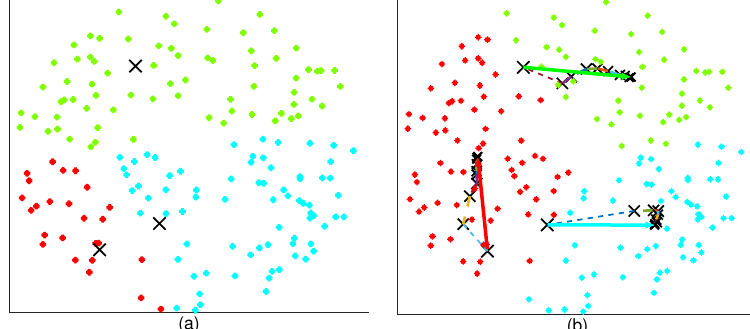
Figure 4. Illustration of the movement of the aerial base stations (ABSs) in the 2D plane for suburban environment. The position of the ABS is represented using x . The three colors differentiate the UE clusters of the respective ABSs. ( a ) Initial 2D position of the ABSS. ( b ) Movement of the ABSs to the computed position. The solid arrow represents the actual ABS movement. The doted lines represent the adaptive process (does not represent the movement) performed at the CC. R B = 2000 m, α N = 2.5, α L = 2, λ U = 2 × 10 − 4 /m 2 , δ = 0, N UAV = 3, H ∗ = 300 m, N T =